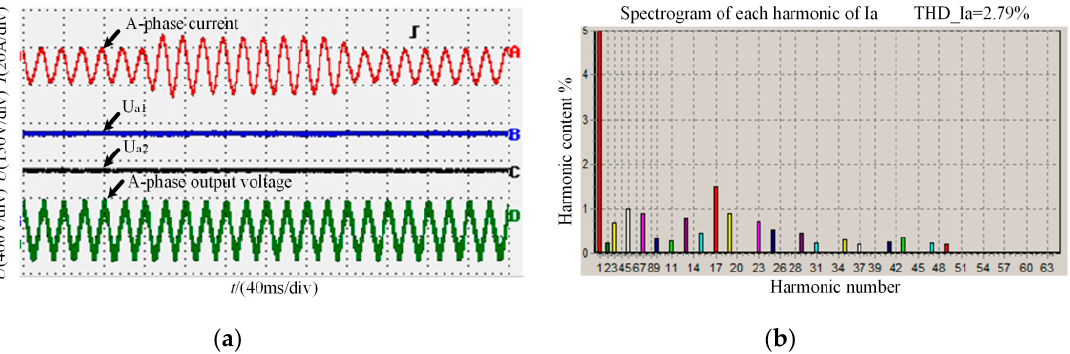
Figure 17. After compensation: ( a ) Grid current, two capacitor voltages, and the output voltage of the A-phase; ( b ) Current THD.